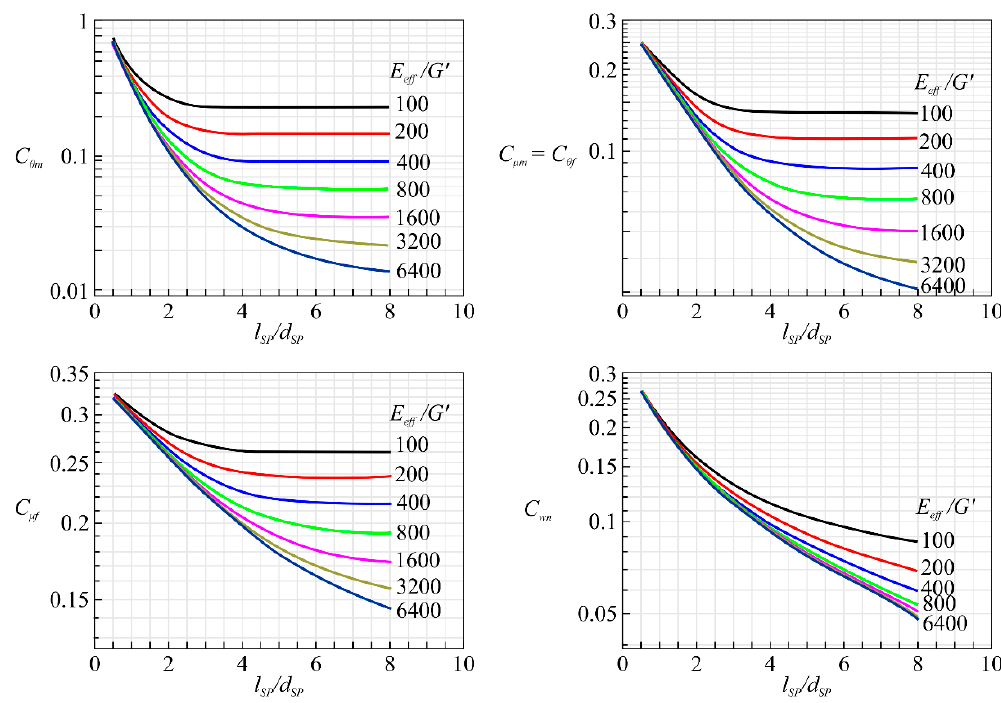
Figure 9. Characteristics of influencing factors.